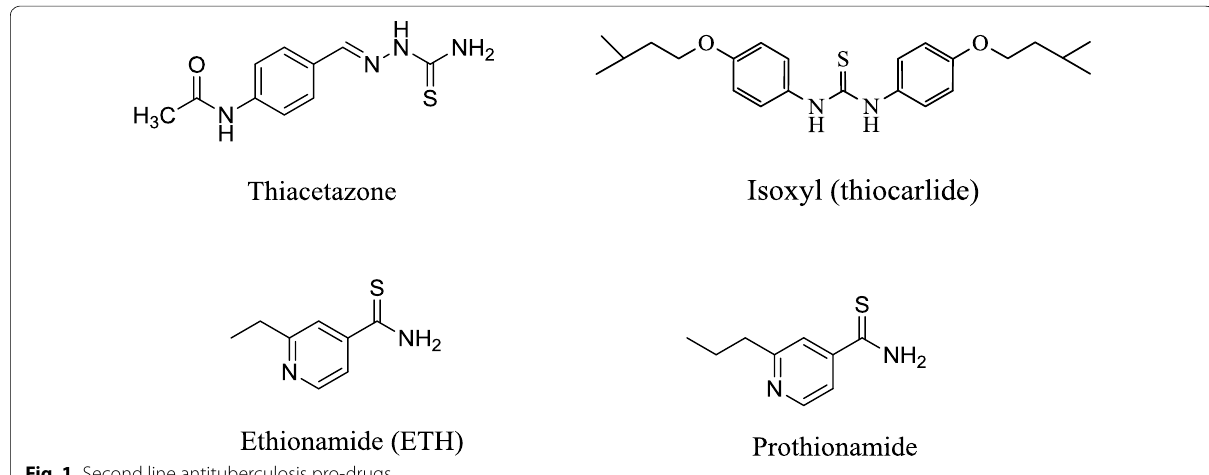
Fig. 1 Second line antituberculosis